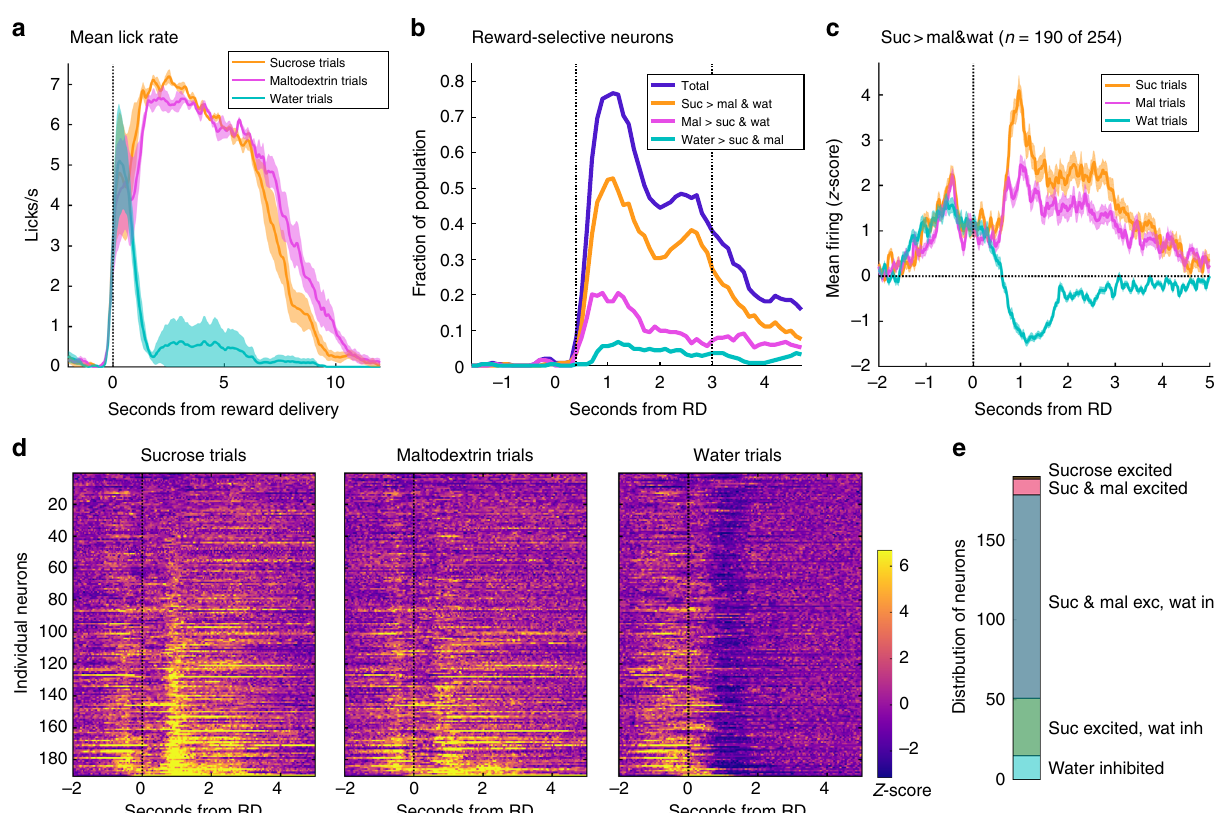
Fig. 6 VP neurons report the relative value of three reward outcomes. a Lick rate on sucrose (orange), maltodextrin (pink), and water (blue) trials. Shading is SEM. b Histogram of the fraction of neurons in VP that meet criteria for reward selectivity relative to reward delivery time. Plotted are the total fraction of reward-selective neurons (dark blue) and, of those, neurons with greatest fi ring for sucrose (orange), maltodextrin (pink), or water (light blue). Dashed lines indicate the window (0.4 – 3 s) for which reward-selective neurons were selected for ( c – e ). c Mean normalized fi ring rate of neurons that are reward- selective for any bin 0.4 – 3 s post reward delivery and have greatest fi ring rate for sucrose. Shading is SEM. d Normalized fi ring rate of individual neurons included in c . Neurons in all three plots are sorted by amount of fi ring on sucrose trials in the bin with the most number of neurons with greatest fi ring for sucrose. e Distribution of neurons in ( c ) and ( d ) according to sucrose excitation, maltodextrin excitation, and water